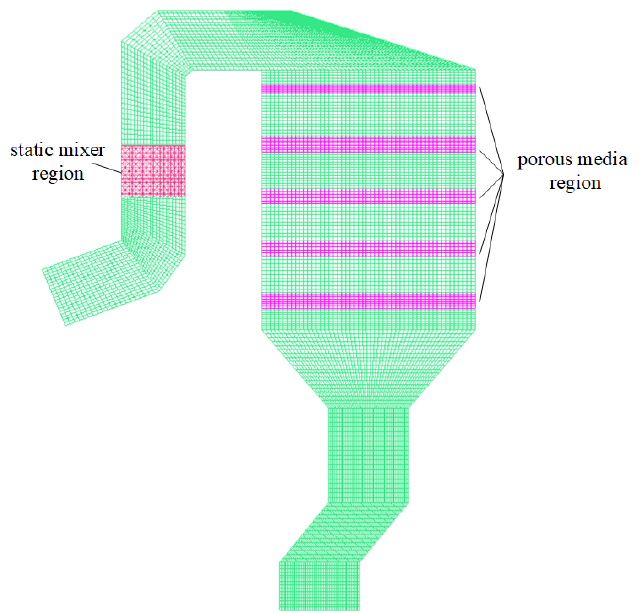
Figure 2. Cross-sectional view of mesh diagram of SCR denitration